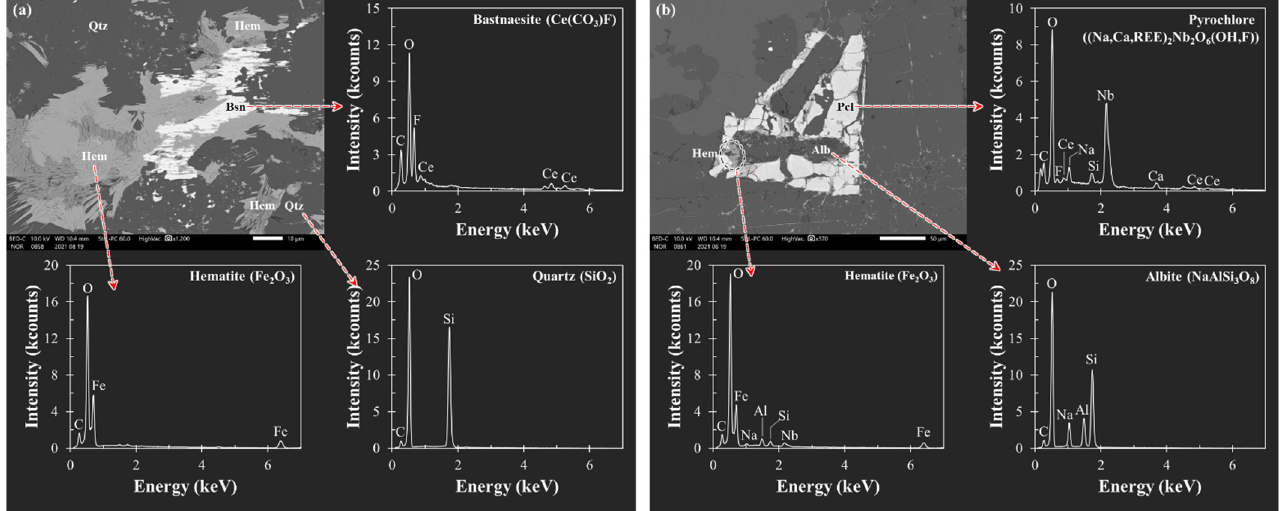
Figure 5. Back-scattered electron (BSE) images and EDS point analyses of ( a ) bastnaesite-hematite-quartz and ( b ) pyrochlore-hematite-albite ores in the sample. Note: Bsn, bastnaesite; Hem, hematite; Qtz, quartz; Pcl, pyrochlore; Alb,